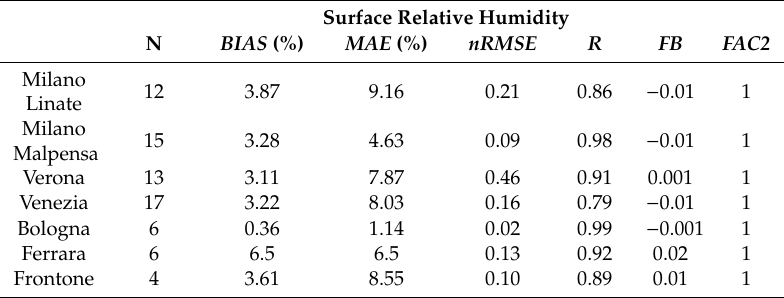
Table 4. Statistical scores of WRF surface relative humidity outputs of the seven selected sites (a negative BIAS means a WRF underestimation and vice versa).